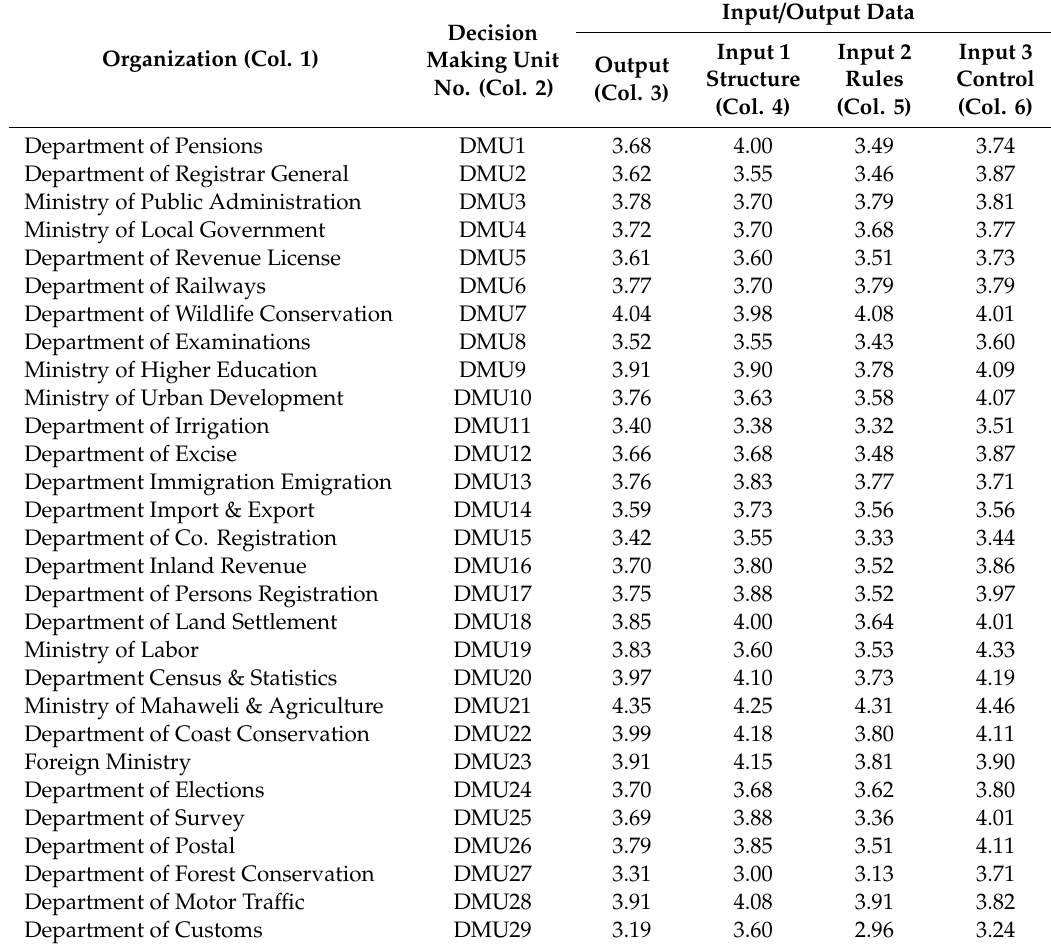
Table 2. Input and Output